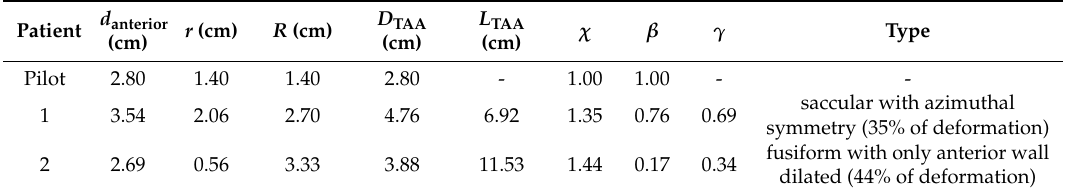
Table 1. Geometrical characteristics of the